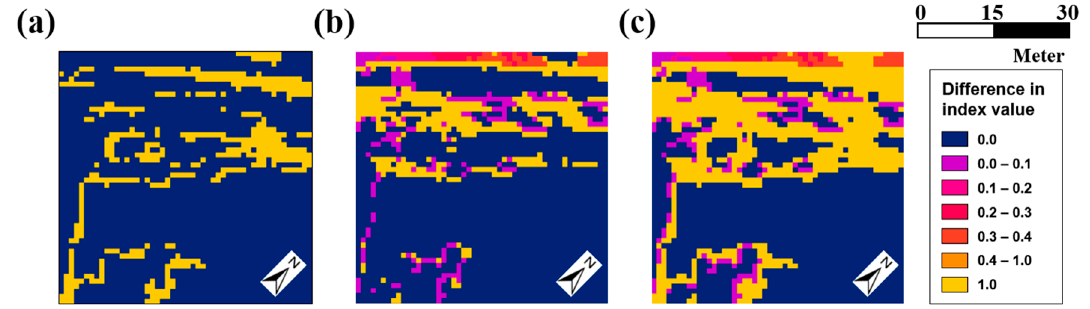
Figure 8. Differences in index maps obtained by ( a ) the LOS analysis and the 2D Fresnel zone analysis, ( b ) the 2D Fresnel zone analysis and the 3D Fresnel zone analysis, and ( c ) the LOS analysis and the 3D Fresnel zone analysis for transmitter 1.